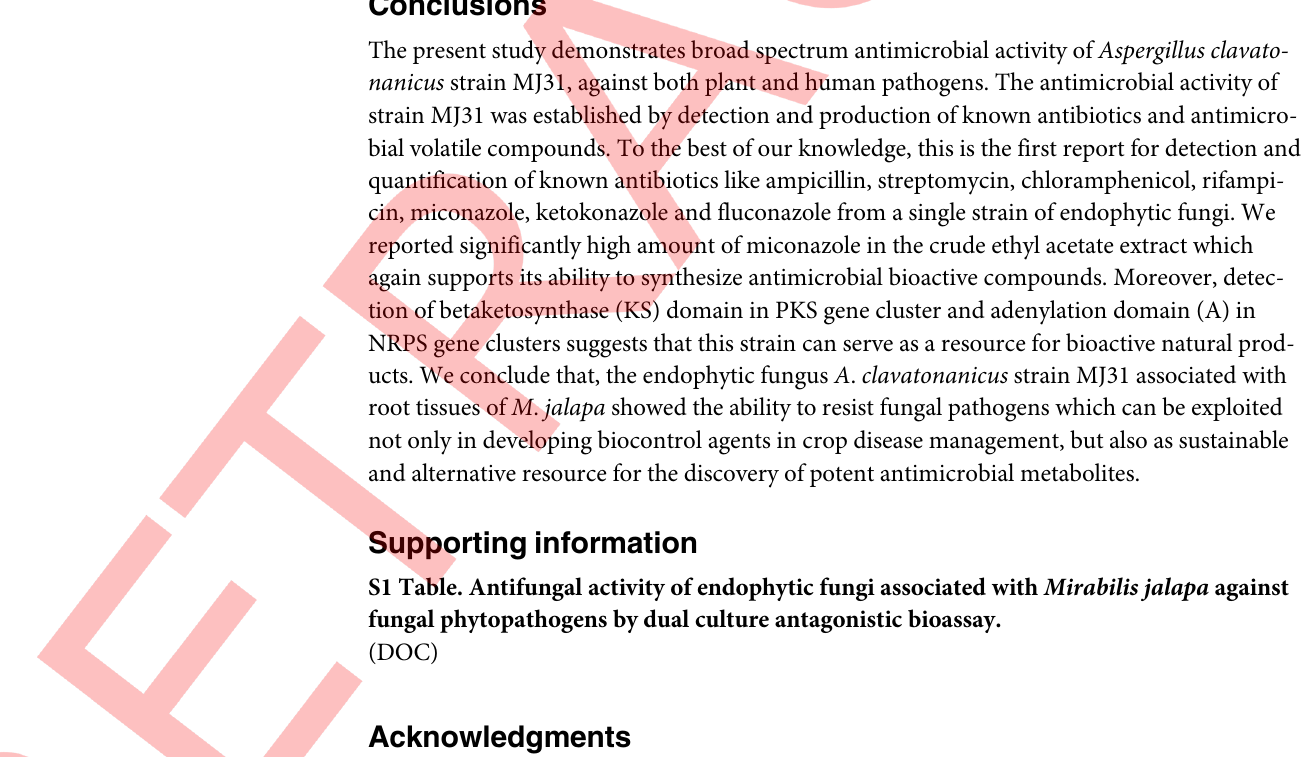
S1 Table. Antifungal activity of endophytic fungi associated with Mirabilis jalapa against fungal phytopathogens by dual culture antagonistic